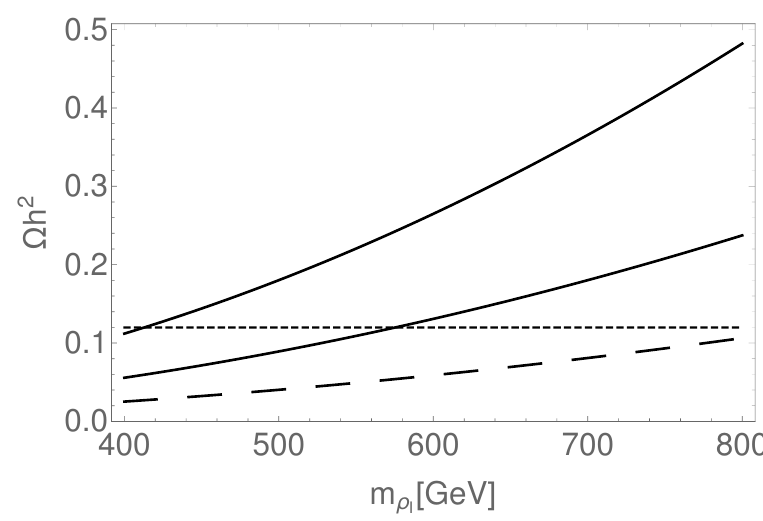
Figure 9 . Relic density Ω h 2 , as a function of the mass m ρ of the ρ I scalar field, for several values I of the quartic scalar coupling α 3 . The curves from top to bottom correspond to α 3 = 1 , 1 . 2 , 1 . 5 , respectively. The horizontal line shows the observed value Ω h 2 = 0 . 1198 [189] for the relic density.